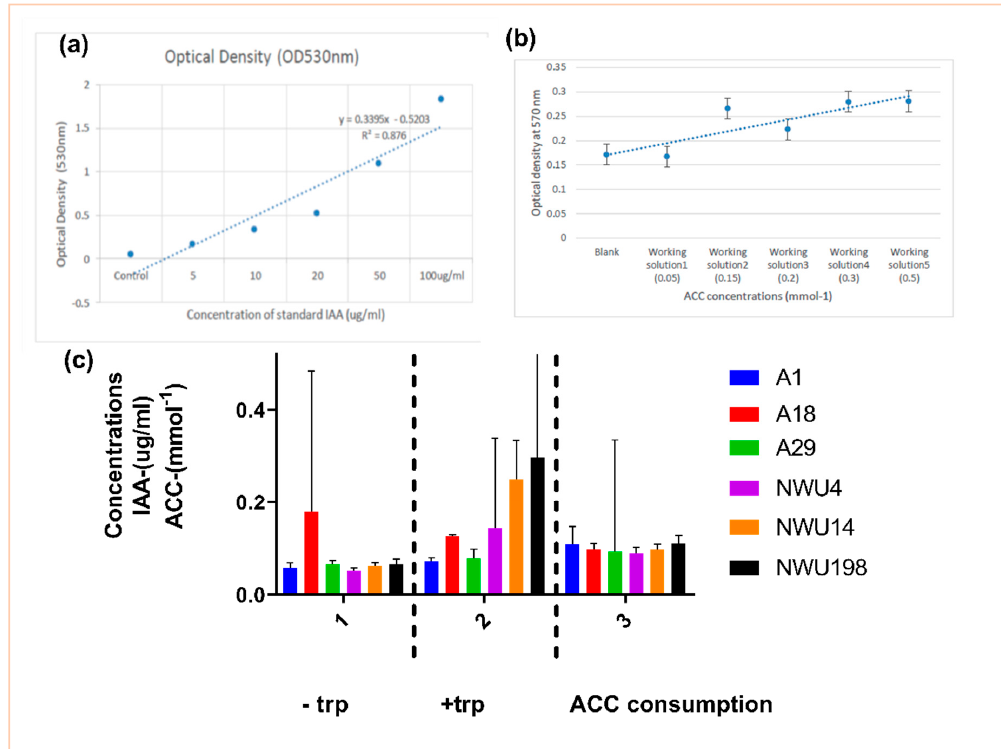
Figure 1. Indole acetic acid (IAA) and 1-aminocyclopropane-1-carboxylic acid (ACC) production by isolates. ( a ) Standard graph of IAA at an optical density of 530 nm. ( b ) Standard curve of ACC concentrations ranging from 0.05 to 0.5 mmol − 1 determined by the 96-well polymerase chain reaction (PCR)-plate ninhydrin assay ( y = 0.0242 x + 0.1467, R ² = 0.7364). Each data point represents the mean of